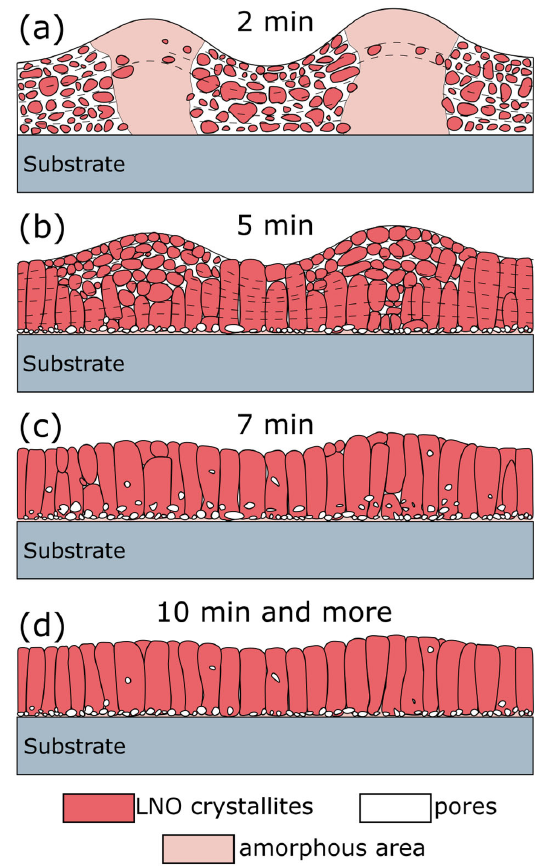
Figure 15. General view of LNO films, prepared at different annealing time of each deposited layer: 2 min ( a ), 5 min ( b ), 7 min ( c ), 10 min, and more ( d ).